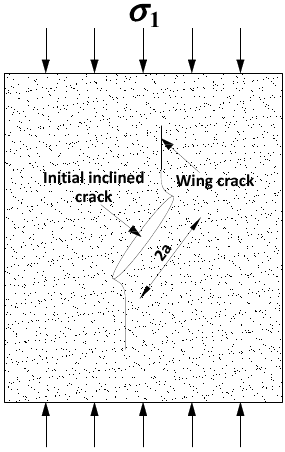
Figure 12. Wing crack initiation under uniaxial compression.